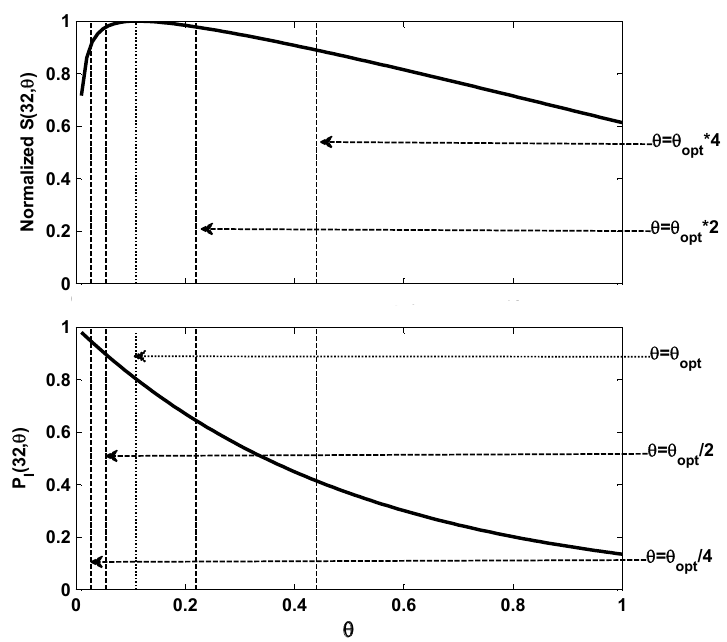
Figure 2. The P I (32 , θ ) and the normalized S (32 , θ ) vary with different θ . Figure 2. The P I ( 32, θ ) and the normalized S ( 32, θ ) vary with different θ